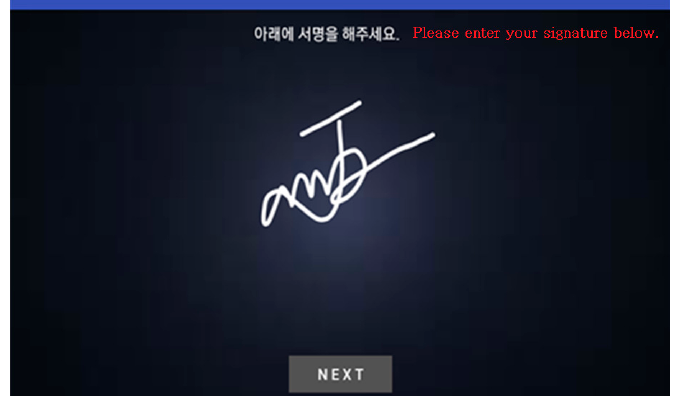
Figure 8. Signature input window for comparison.